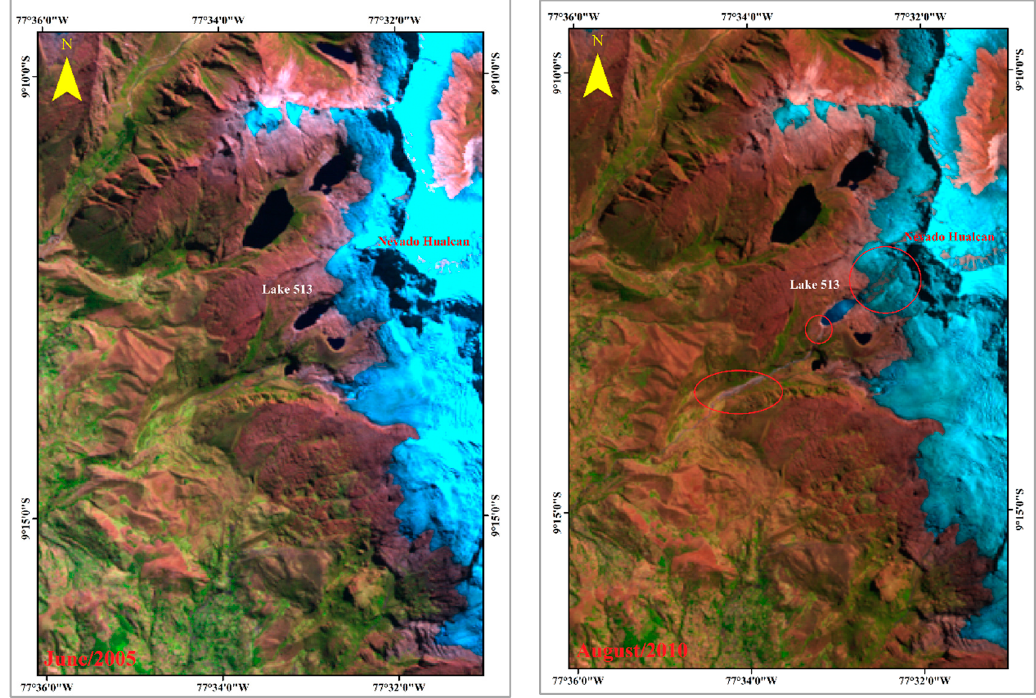
Figure 5. The Chucchun Valley in the Cordillera Blanca, Peru, before ( left ) and after ( right ) the 2010 GLOF at Lake 513. Movement of sediments and the direction of ice avalanches are highlighted.